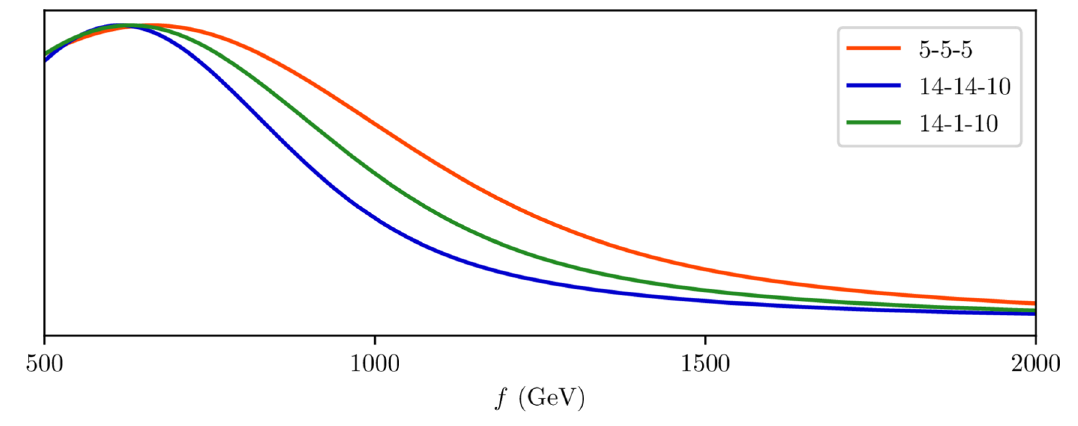
Figure 10. Priors for the Higgs decay constant f in each model. These priors are not put in by hand, but are the result of fixing f to give the correct EWSB scale for each